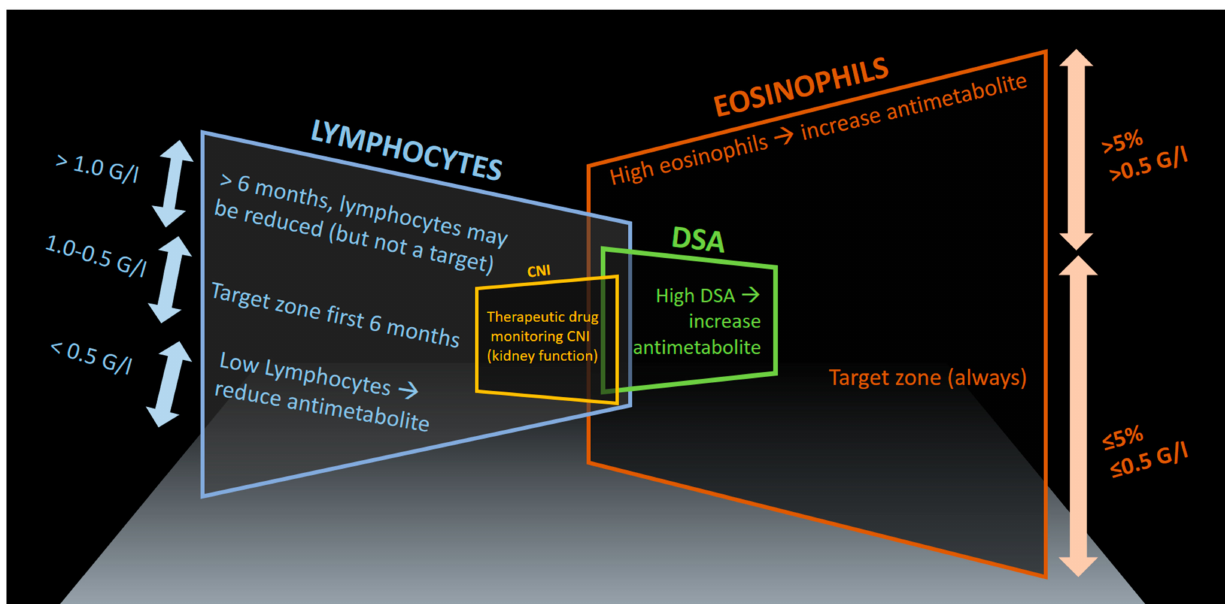
Figure 1. Adaptive immunosuppression considering differential white blood cell counts (eosinophils, lymphocytes) and other factors (therapeutic drug monitoring levels of calcineurin inhibitors (CNI), kidney function, and donor specific antibodies (DSA). We refer to this concept as the “Rule of Five” (the number five appearing in many of the main target values), showing graphically the components of the immunosuppressive therapy including target zones of lymphocytes and